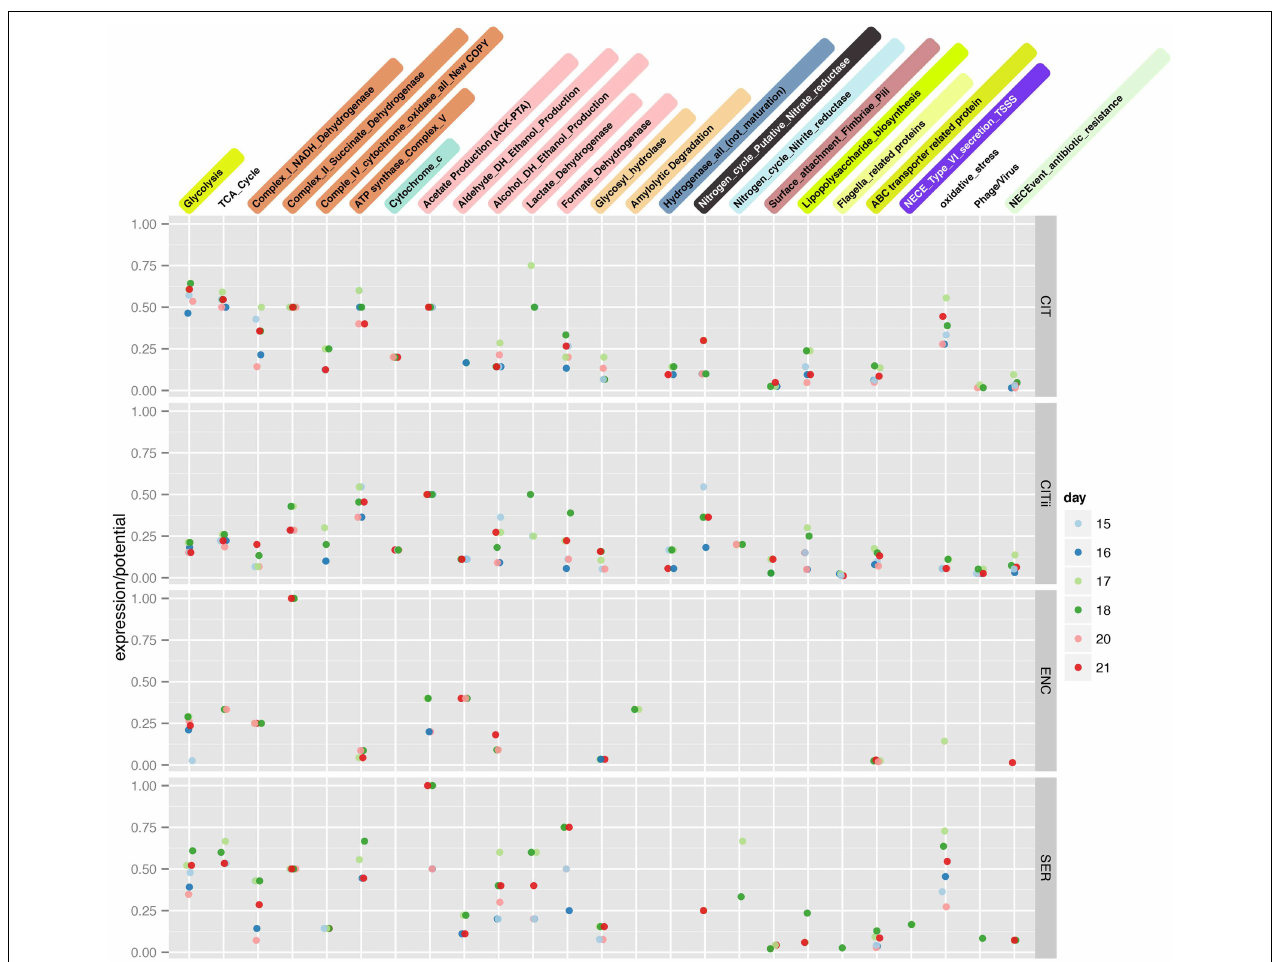
FIGURE 3 | Expression over potential (genomic content) ratio of infant gut microbes. A non-redundant count of the number of features identified via proteomics in a metabolic ggKbase list was divided by the number of features in that list and plotted for each organism across time.